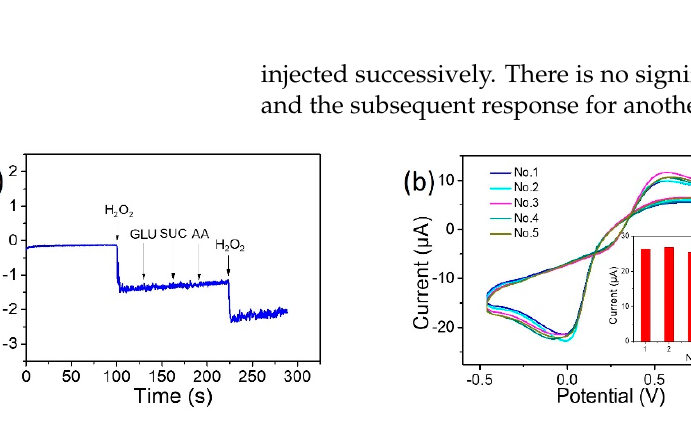
Figure 8. ( a ) The amperometric response of the Pt 50 Pd 50 aerogel modified GCE with respective additions of 2 µ M H 2 O 2 , 2 mM glucose, 2 mM saccharose, 2 mM ascorbic acid, and 2 µ M H 2 O 2 in N 2 -saturated 0.1 M 20 mL PBS at − 0.05 V. ( b ) The current responses of five different Pt 50 Pd 50 aerogel modified GCEs synthesized under the same conditions at a concentration of 1 mM H 2 O 2 . The inset picture is the current responses calculated in the form of bar charts. ( c ) An example of stability test of one Pt 50 Pd 50 modified GCE over 6 days in the air at room temperature. The inset picture